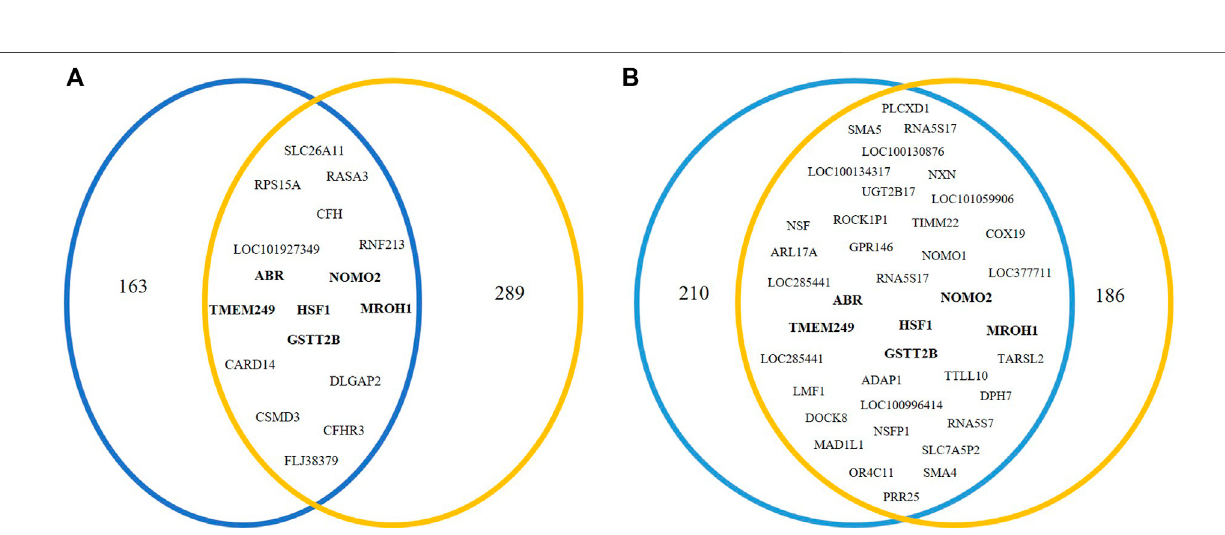
Frontiers in Genetics |